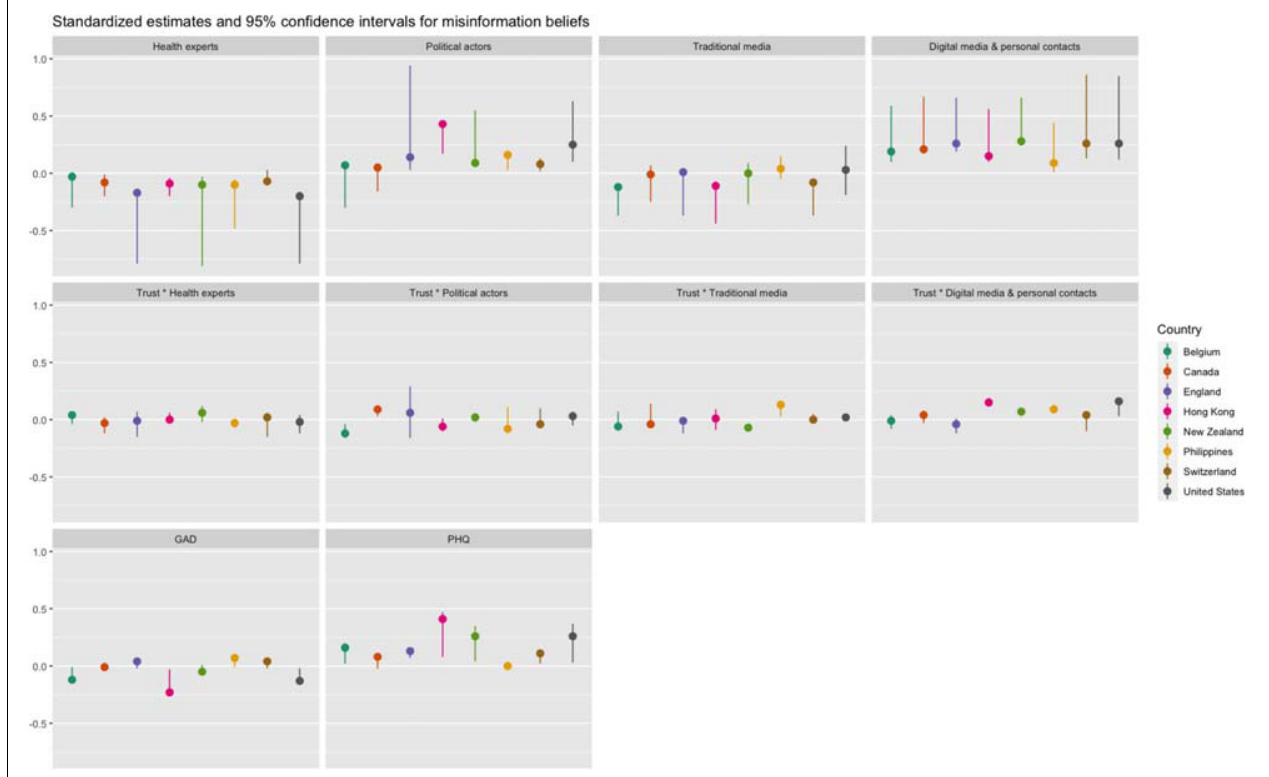
FIGURE 2 | Direct standardized effects of predictors on misinformation beliefs per